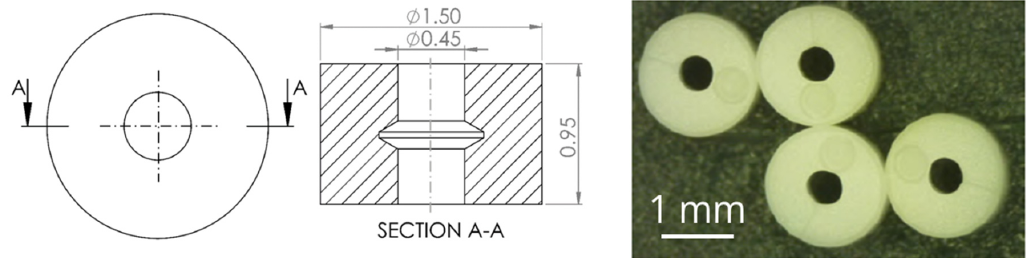
Figure 2. Design specification of the polymer micro-ring ( left ) and micro-molded parts ( right ) [30].